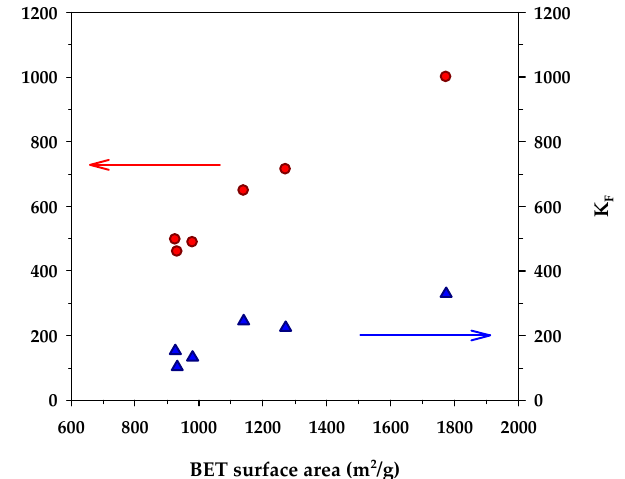
Figure 5. Effect of BET surface area on monolayer capacity ( q m ) of the Langmuir isotherm equation and K F of the Freundlich equation.